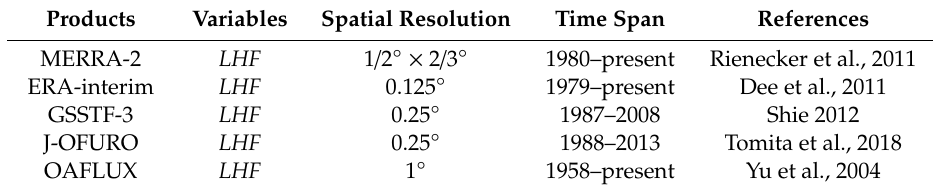
Table 1. Summary of the five ocean LHF products in this study for 2003–2007.